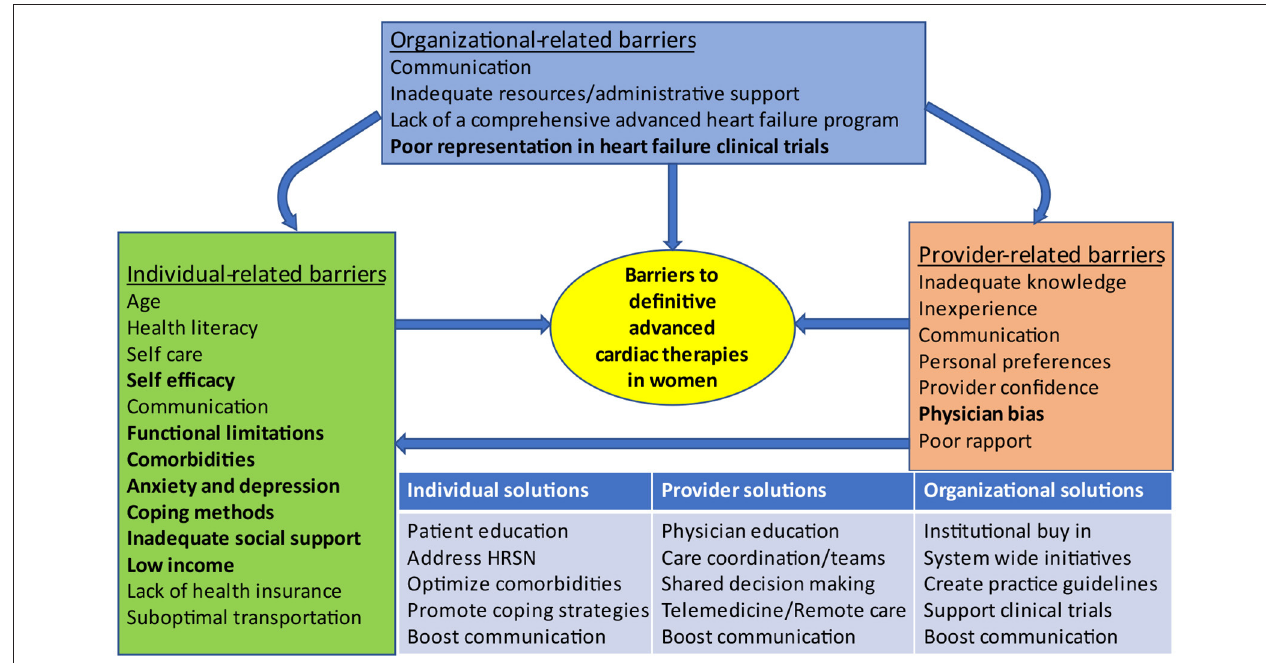
FIGURE 3 | Barriers to advanced heart failure therapies in women and proposed solutions. Organizational-related barriers can influence individual-related and provider-related barriers. Provider-related barriers can influence individual-related barriers. Factors that are more common in women appear in bold. HRSN, Health related social